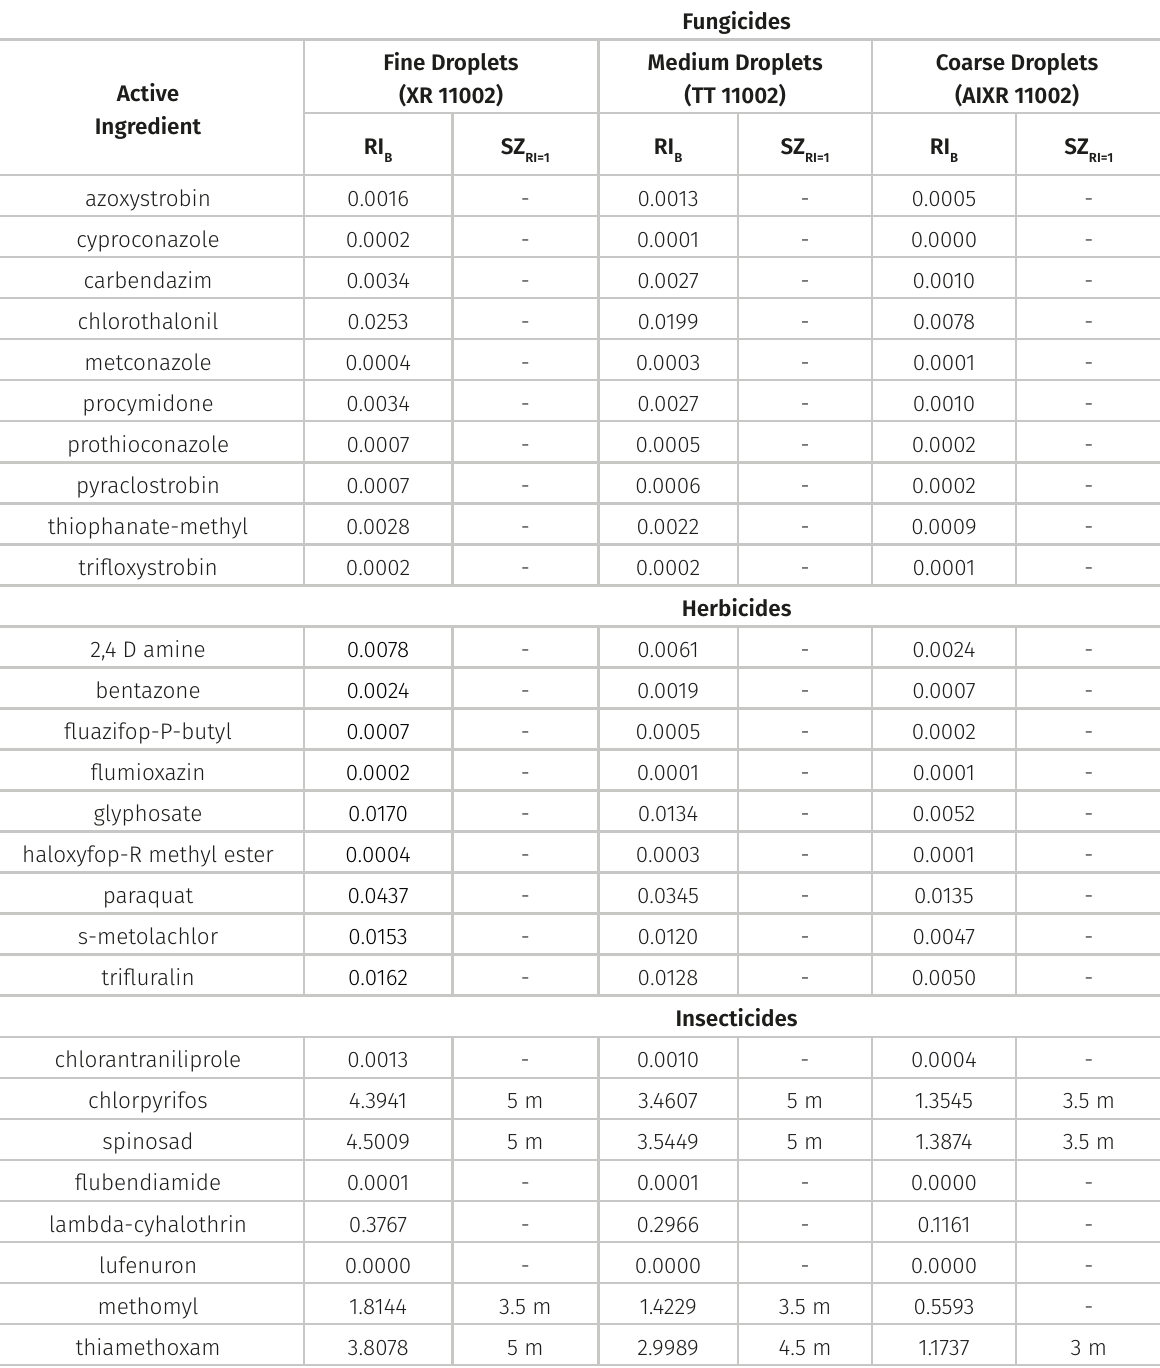
Table VIII. Risk indices and buffer zones for bees due to drift 2.5 m from the target area due to the application of recommended phytosanitary products for the control of diseases, weeds and pests in the soybean